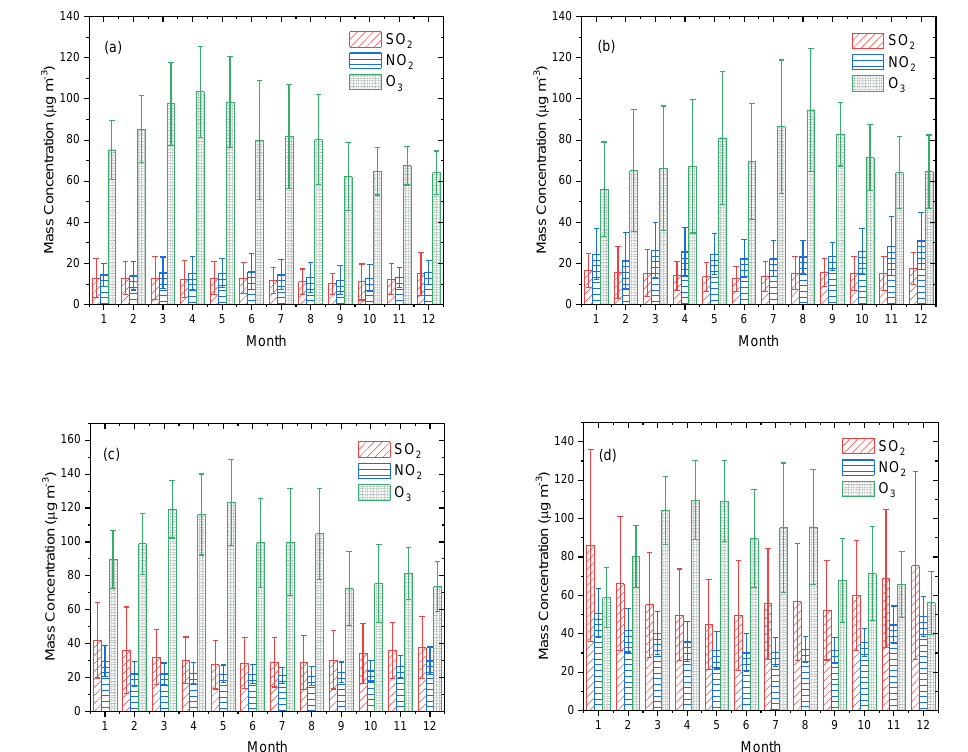
Figure 11. Monthly mean mass concentrations of SO 2 , NO 2 , and O 3 in ( a ) Aba, ( b ) Ganzi, ( c ) Liangshan, and ( d ) Panzhihua.